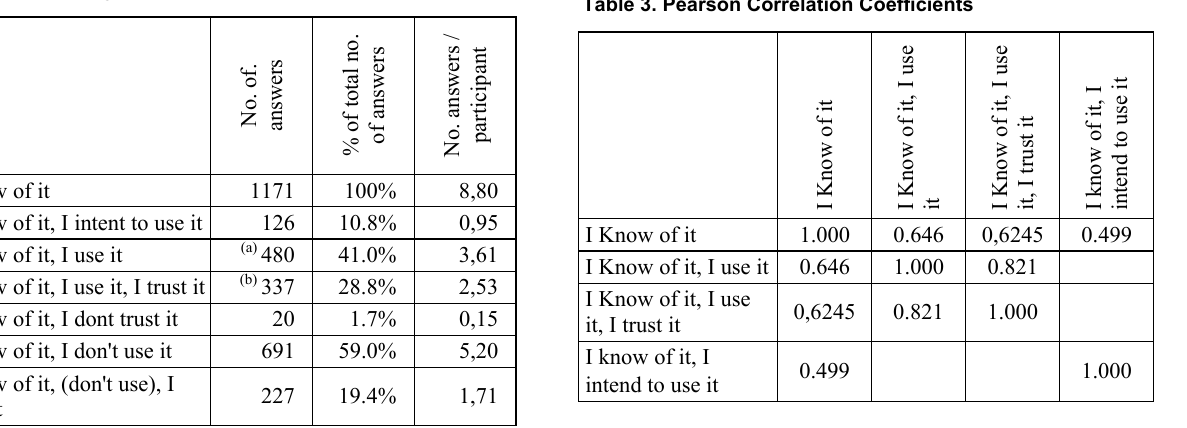
Table 2. Summary of answers